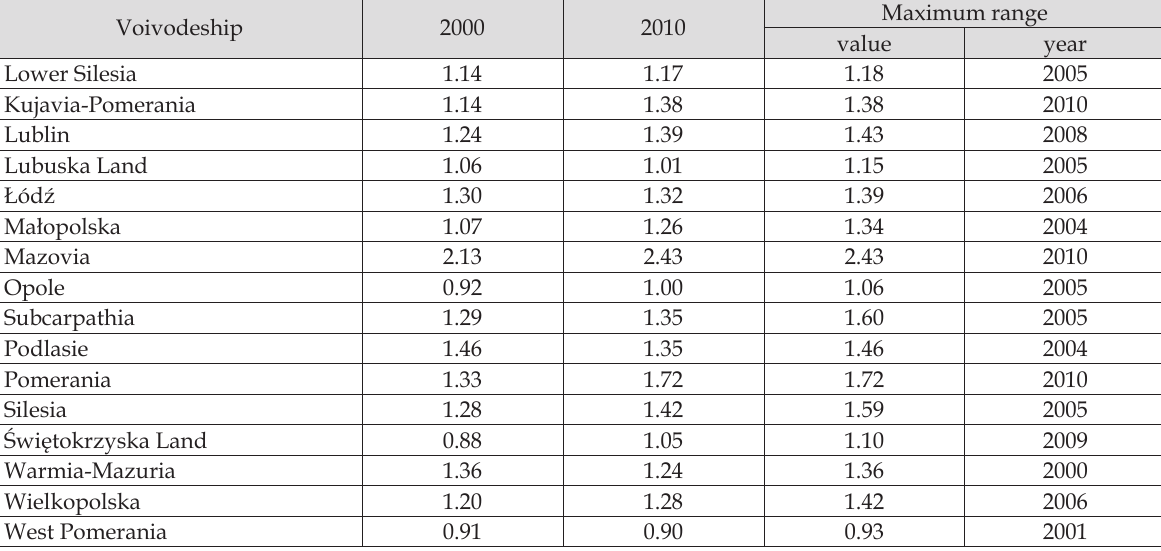
Table 6. Range of values of Perkal’s synthetic index for poviats by NUTS 2 units: a general